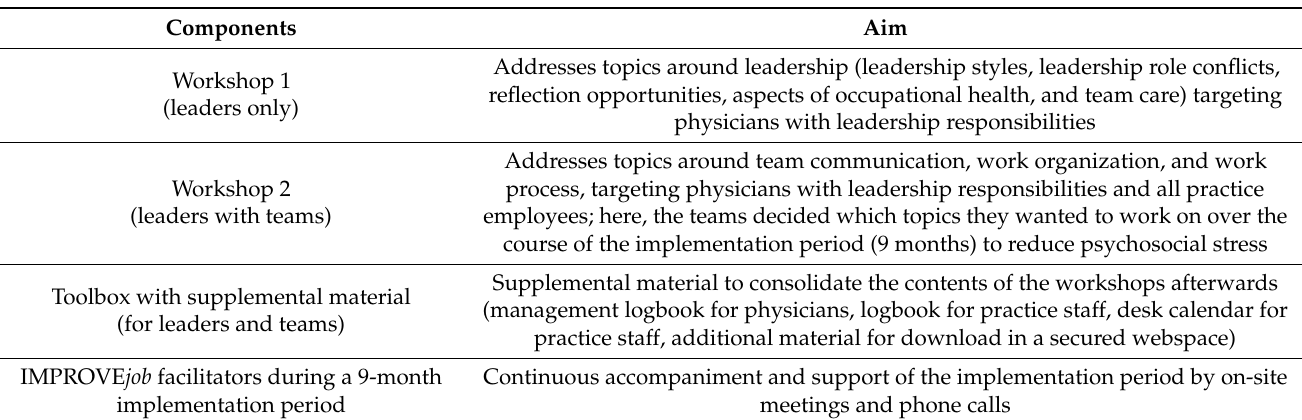
Table 1. Overview of components of the IMPROVE job intervention